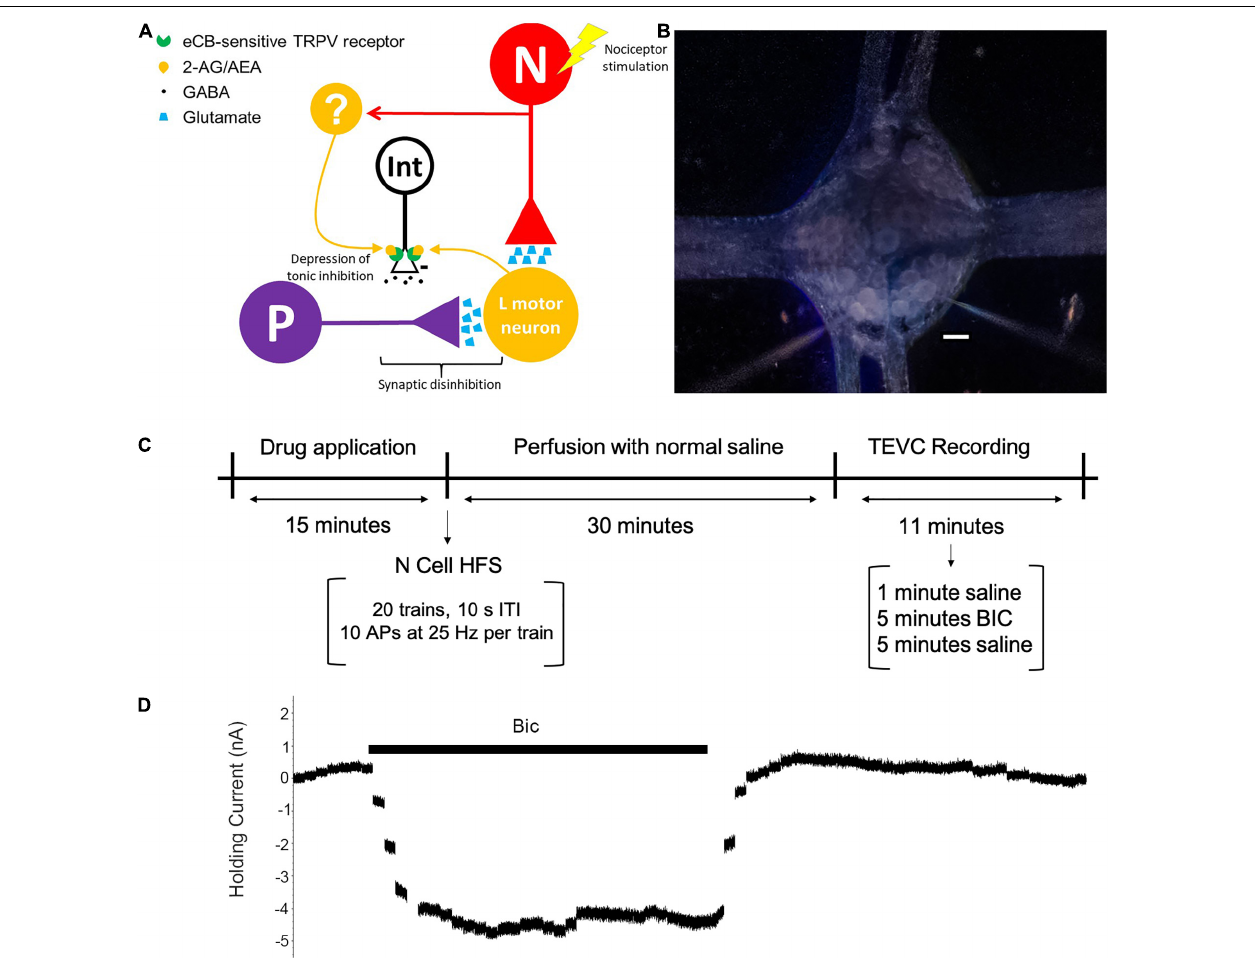
FIGURE 1 | (A) Proposed circuit for N cell-initiated disinhibition of P cell synapses through activity-dependent endocannabinoid modulation. The N and P afferents have converging inputs onto multiple postsynaptic targets, including the longitudinal (L) motor neuron. An unidentified GABAergic interneuron (Int) has tonic